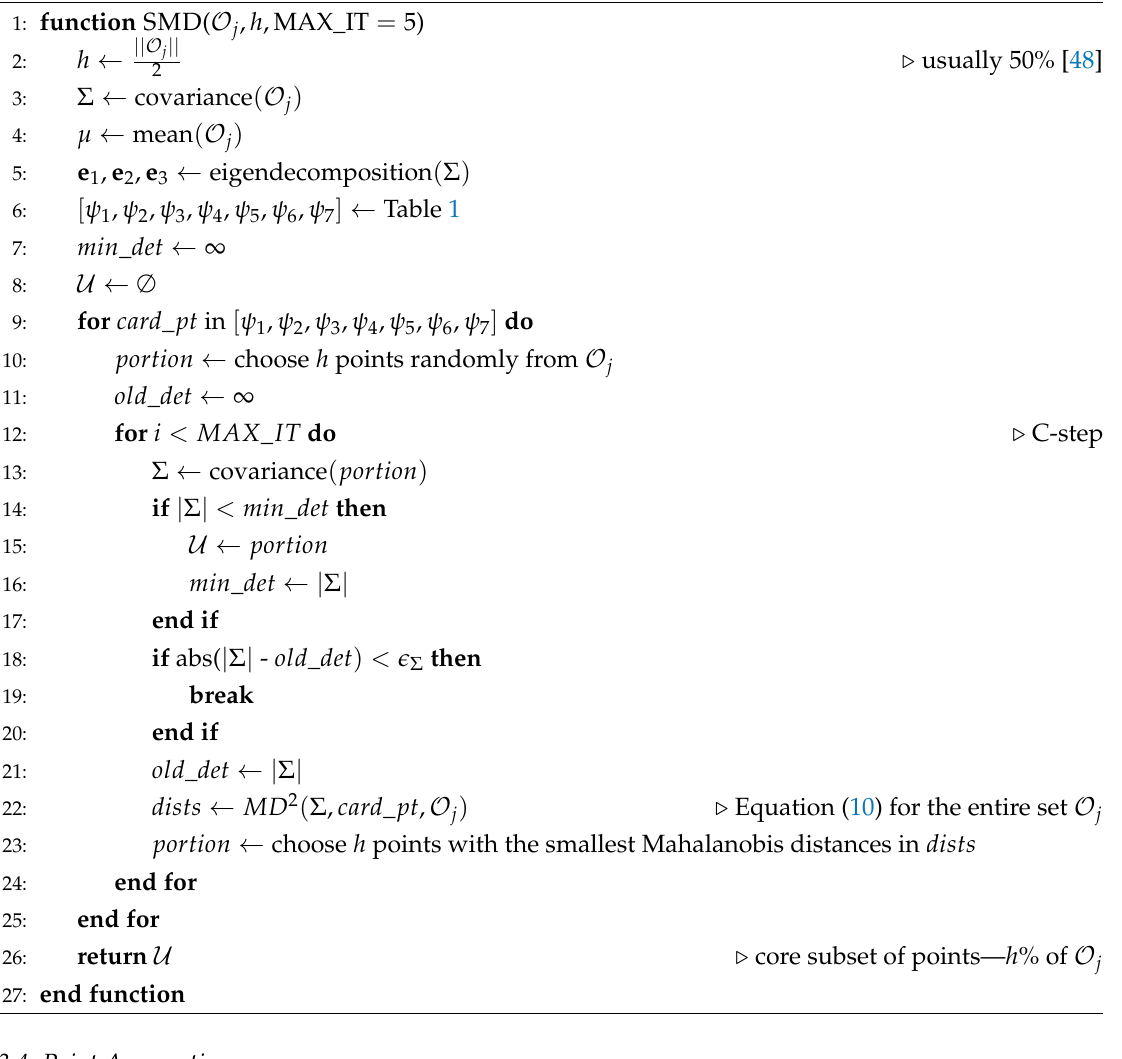
Algorithm 2 Shifted Mahalanobis Distance (SMD) based core points determination of a set O